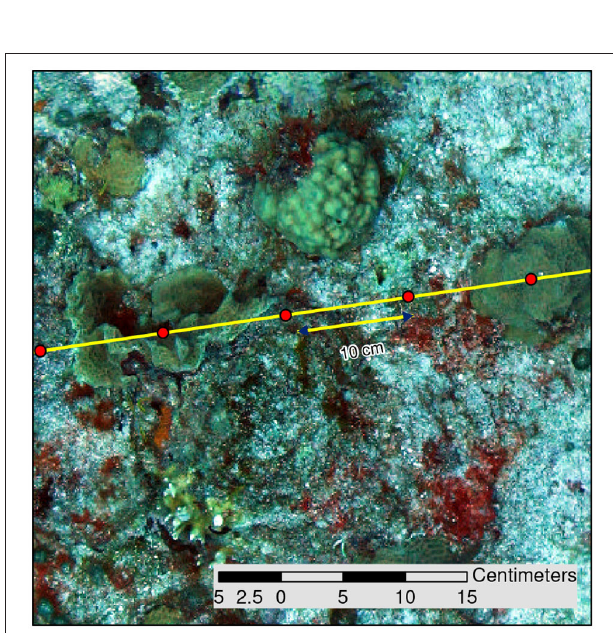
FIGURE 4 | Simulated transect line, where the identity of the substrate was assessed every 10 cm.